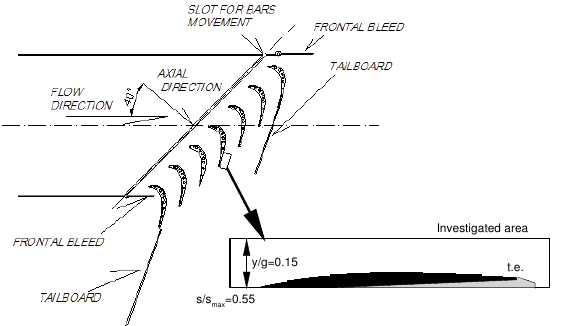
Figure 1. Schematic of the test section and particle image velocimetry (PIV) investigated area. Upstream wakes have been simulated by means of a tangential wheel of radial rods installed 1/3 of the axial chord upstream of the cascade leading edge plane. The flow coefficient was set to ϕ = 0.675 analyzed ( f + = 0.69 and f + = 0.35) referred to in the following as nominal and halved condition, respectively. The bar diameter (3 mm) was chosen so that the wake shed from the bars produce losses and shedding frequencies that are representative of those generated by a typical upstream LPT